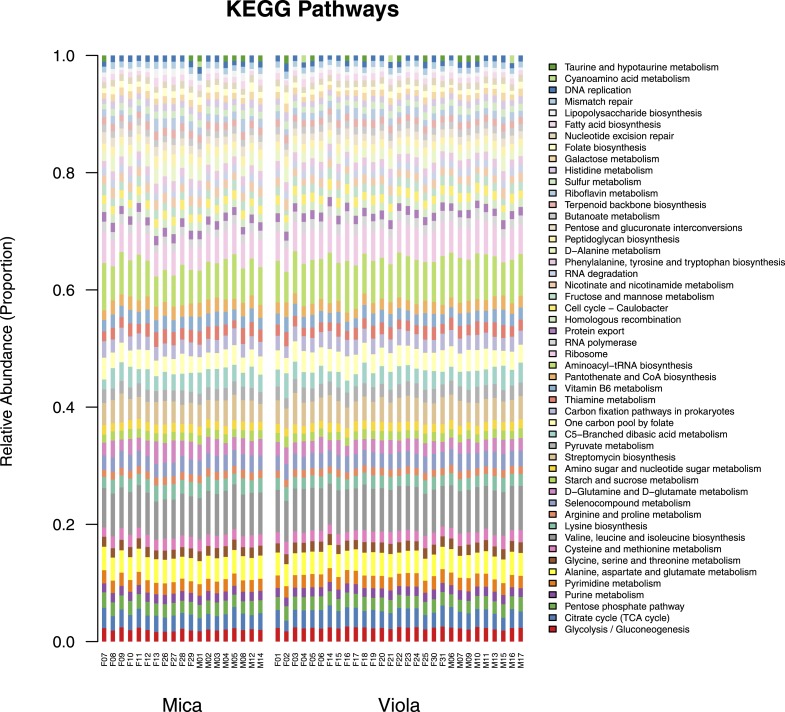
Proportional representation of common KEGG orthologs in each sample, summarized as pathways.The KEGG pathway abundances generated using HUMAnN were filtered to only include those represented at ≥ 1% in at least one sample and are presented as stacked bar plots. Samples from Mica's group are clustered on the left and those from Viola's group on the right.